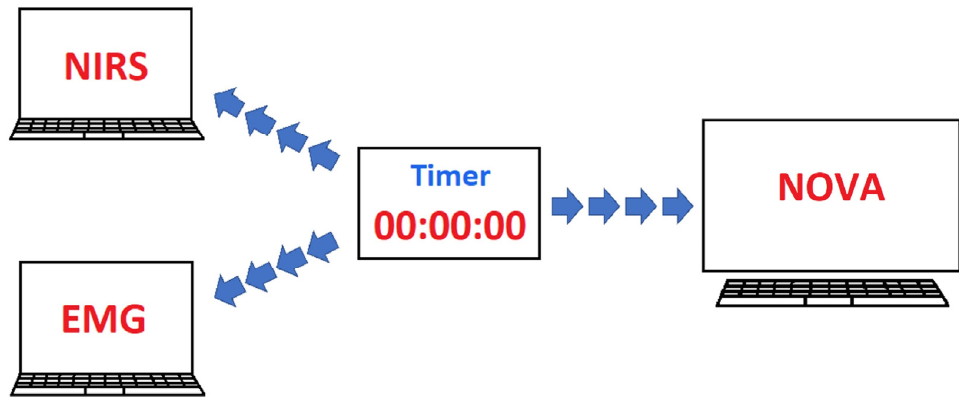
Figure 4. Communication diagram between different devices in the NCVI/NMFI setup. A timer was used for syncing signals between NOVA, NIRS, and EMG, by manually pushing a key on the keyboard of each computer upon a 5 s countdown approaching each event during the assessment.